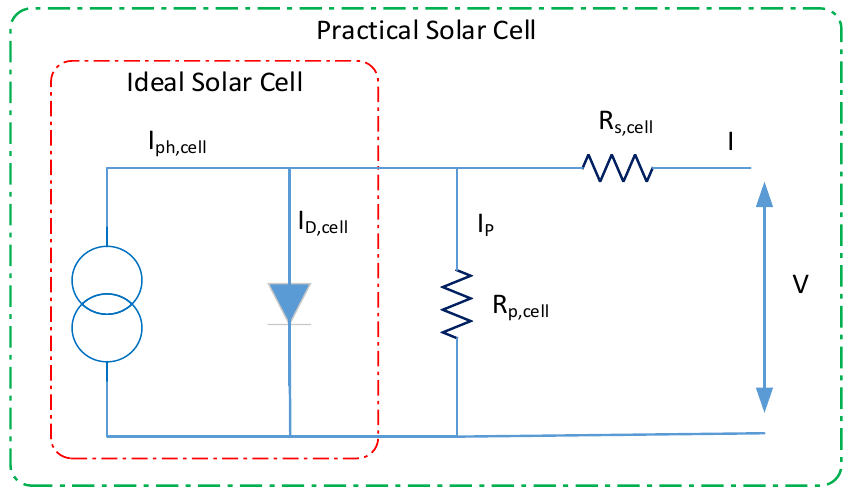
Figure 2. Equivalent circuit of photovoltaic.